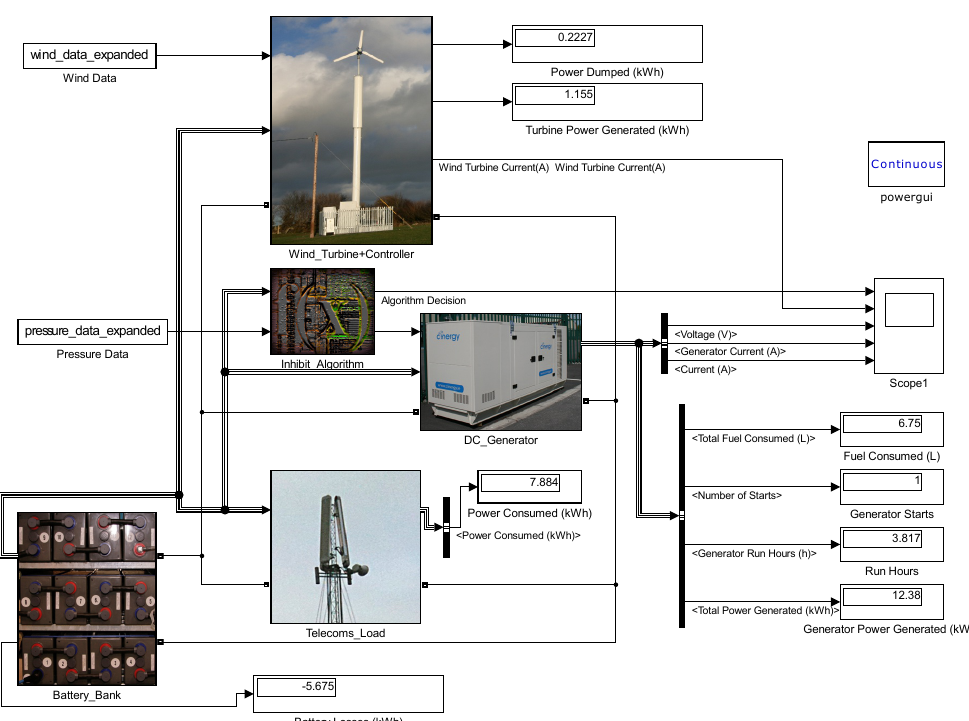
Figure 6. Overview of HSRES in